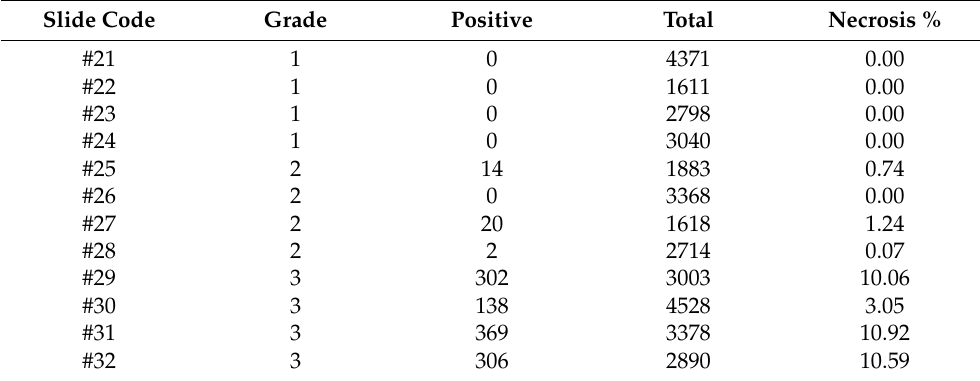
slide code, tumour grade, number of patches containing necrosis (positive), number of positive and negative patches (total) and % of necrosis present in each